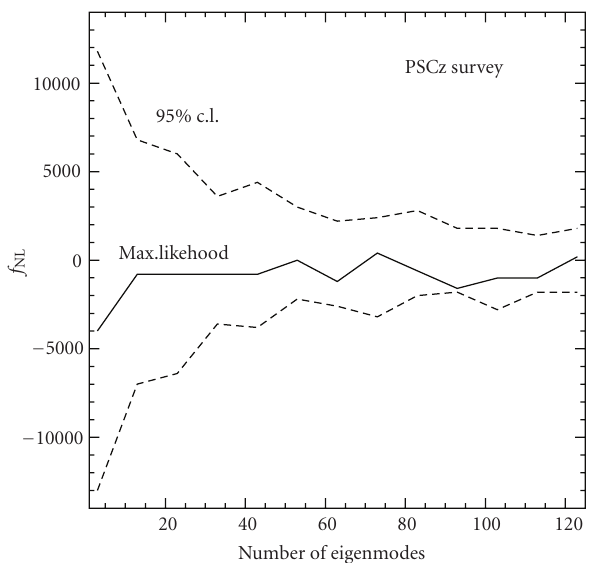
Figure 19: 95% confidence limits on f NL from the PSCz galaxy bis- pectrum after marginalization over bias parameters, as a function of the number of eigenmodes included in the likelihood analysis, from the study by Scoccimarro et al. in